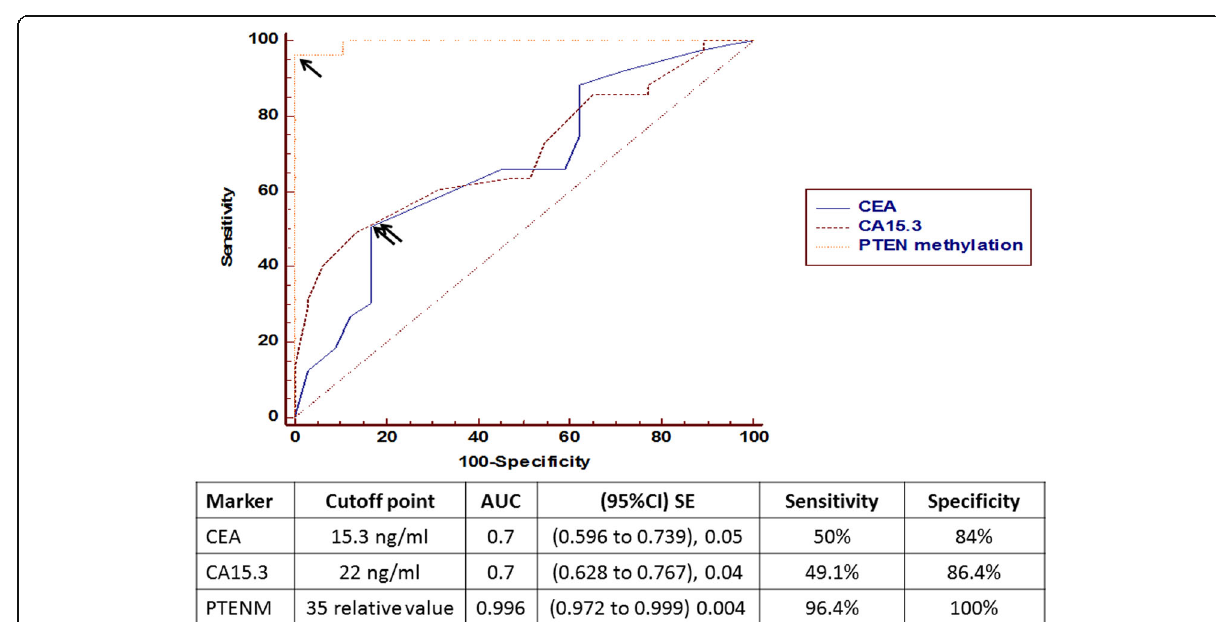
Fig. 2 Receiver operating characteristic (ROC) curve for investigated